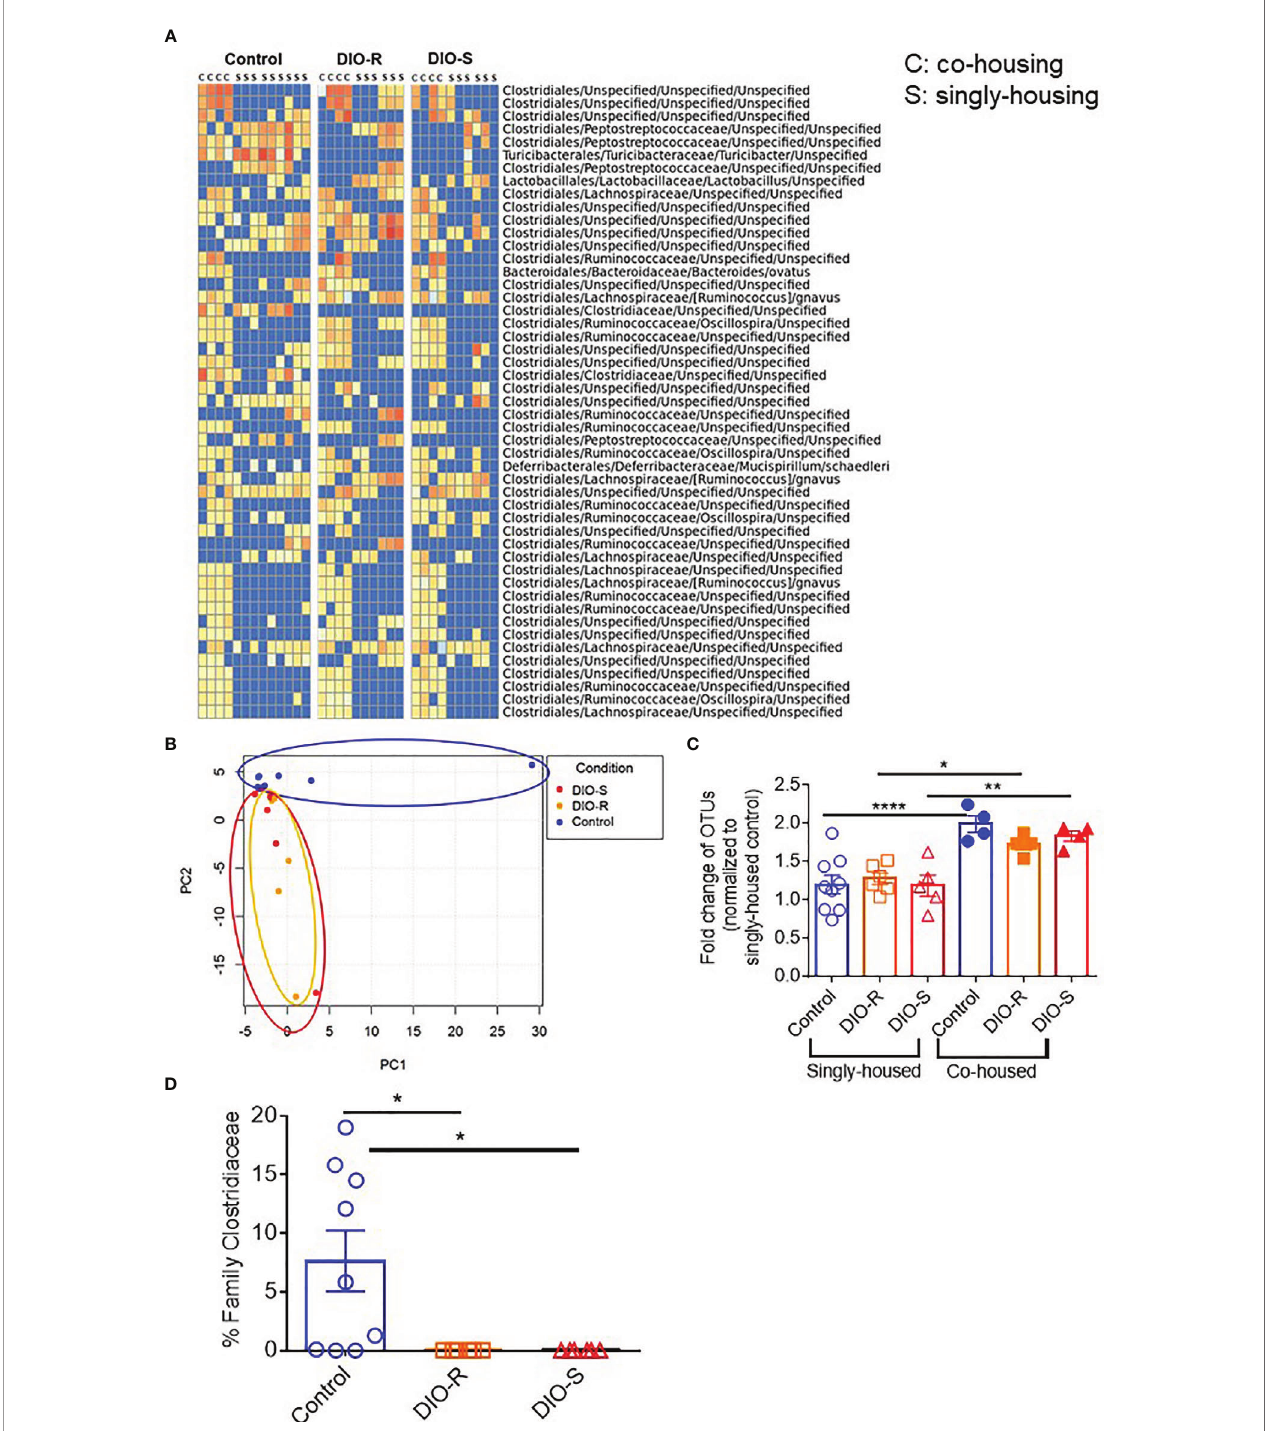
FIGURE 6 | (A) Taxonomic pro fi les of resting control, DIO-R, and DIO-S BALB/c mice being co-housed or singly housed for 4 months (n=4-9/group). (B) Principle component analysis (PCA) of microbiome pro fi les of singly-housed control, DIO-R, and DIO-S BALB/c mice (n=6-9/group). (C) Fold change of OTUs in singly-housed versus co-housed control, DIO-R, and DIO-S BALB/c mice (n=4-9/group). (D) Abundance of family Clostridiaceae of singly-housed control, DIO-R, and DIO-S BALB/ c mice (n=6-9/group). Bar graphs depict mean ±s.e.m. One-way ANOVA test was used in (C, D) . *p < 0.05, **p < 0.01, ****p <